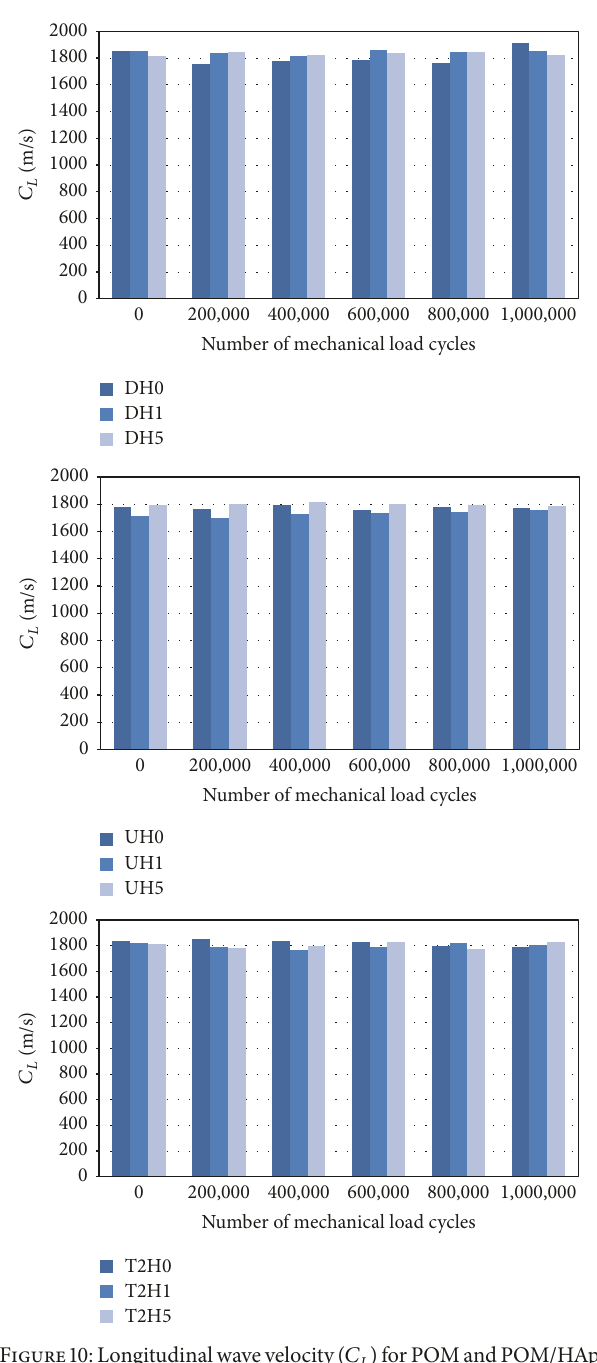
Figure10:Longitudinalwavevelocity( 𝐶 𝐿 )forPOMandPOM/HAp nanocomposites after dynamical